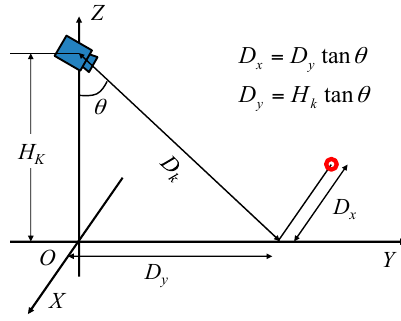
Figure 20. Method of estimating the position ( D x , D y ) of the dynamic hazardous object.